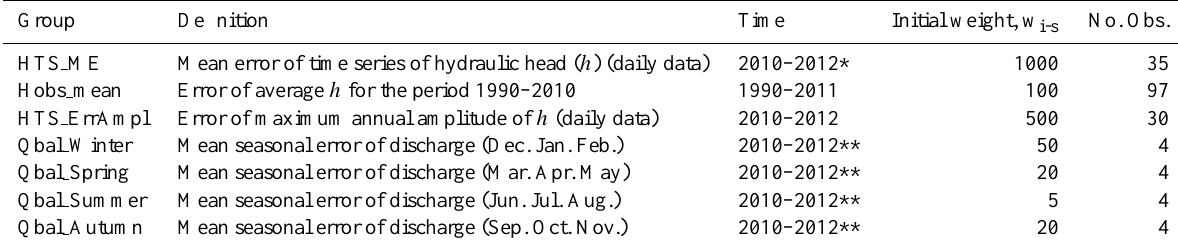
Table 1. Definition of groups in the objective function. Group Definition Time Initial weight, w i-s No. Obs. HTS ME Mean error of time series of hydraulic head ( h ) (daily